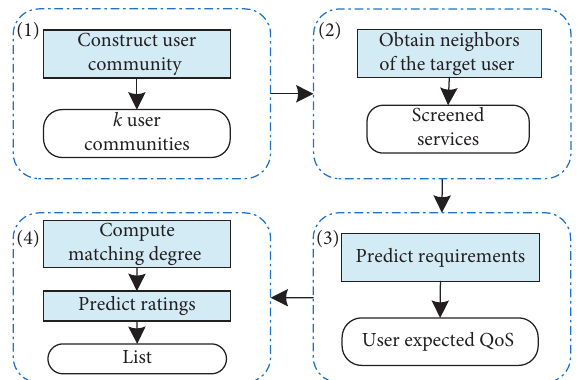
Figure 1: Recommendation